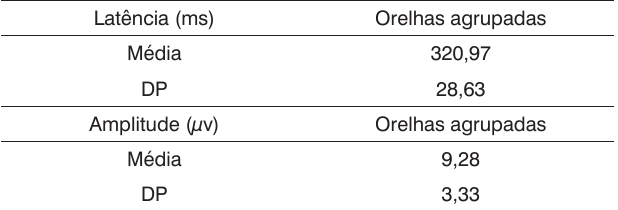
Tabela 2. Média e Desvio Padrão (DP) referentes às latências e amplitudes do P300 para estímulos não verbais, orelhas direita e esquerda agrupadas (n = 30).